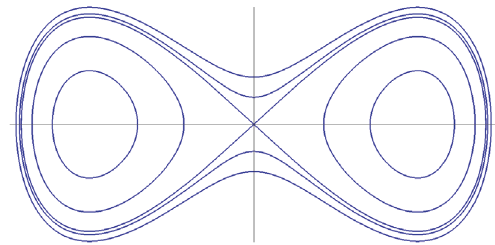
Figure 6: Phase-portrait of (36) for 𝑓(𝑥) = 𝑥 3 and 𝑉 = 2. For graphical reasons a slightly different 𝑥 - and 𝑦 -scaling has been used.